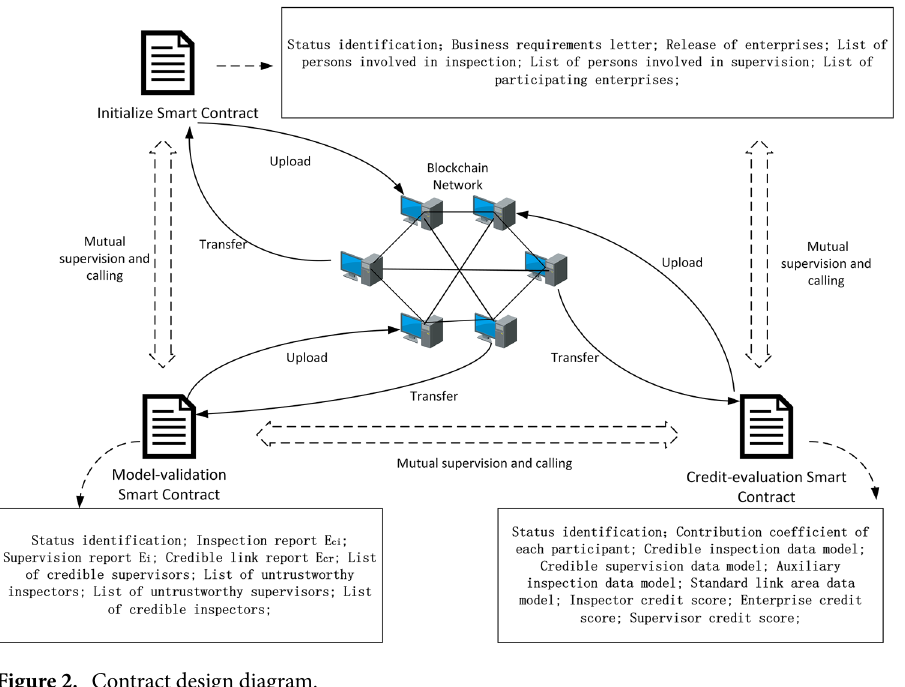
Figure 2. Contract design